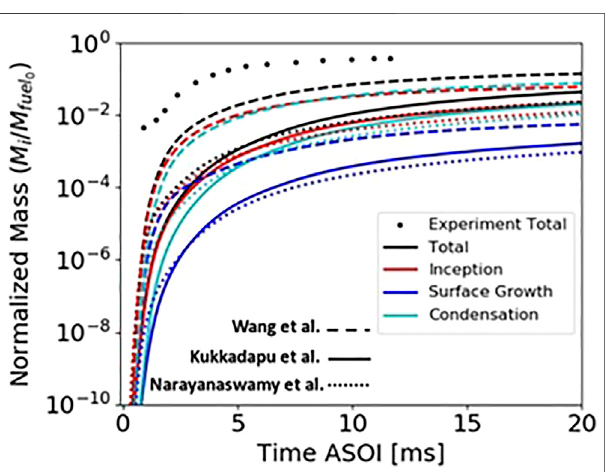
FIGURE 5 | Cumulative soot mass normalized by mass of injected fuel versus time ASOI with contributions from different sub-models for the PSM soot model with the Kukkadapu et al. (2021) Narayanaswamy et al. (2014), and Wang et al. (2014) mechanisms.